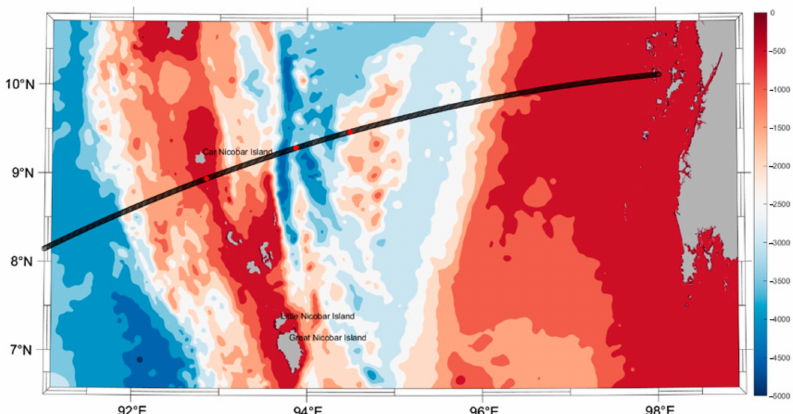
Figure 1. Bathymetry of the Central Andaman Sea. The black line shows the cross-section that is used for the 2D-V modelling. The red dots indicate the generation (westernmost dot) and the model output locations (to the east).